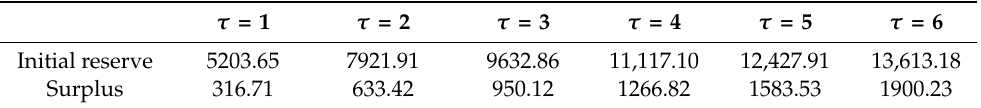
Table 8. Initial reserves for a quota q = 0.3, α / S = 0.4 and ruin probability Φ ( u , τ ) / Φ ( u ) = 0.01 and the resulting surplus at time τ